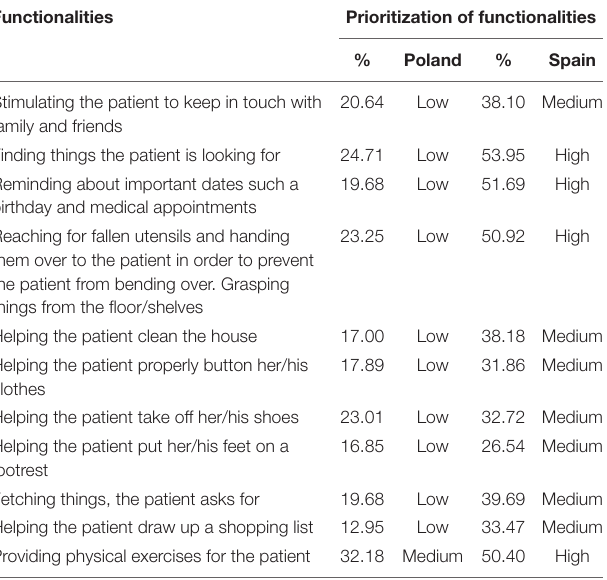
Table 8 | The differences in prioritization among Polish and spanish respondents regarding functionalities of robotic assistant. Functionalities